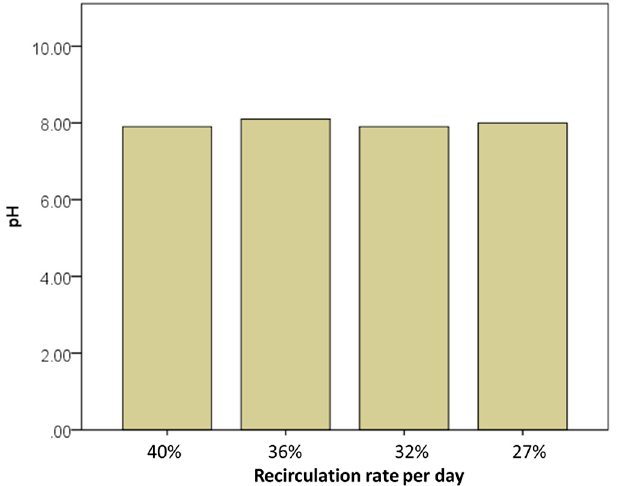
Figure 8. pH as a function of recirculation rate.